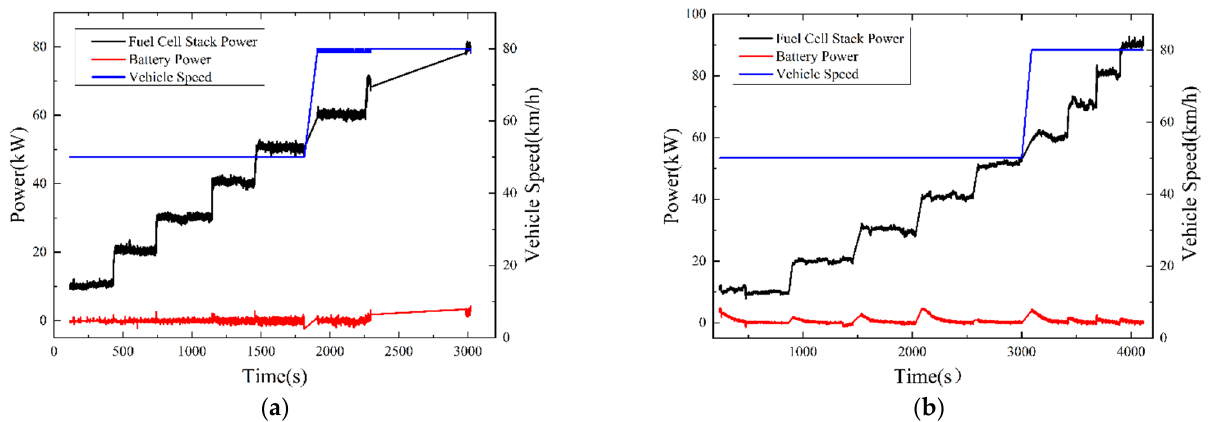
Figure 6. Vehicle speed, fuel cell stack power, and power battery power in constant power mode: ( a ) Vehicle A; ( b ) Vehicle B.